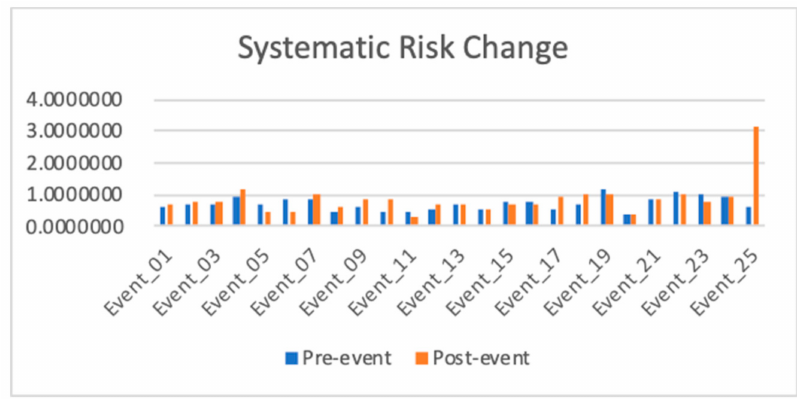
Figure 2. Pre-event and post-event